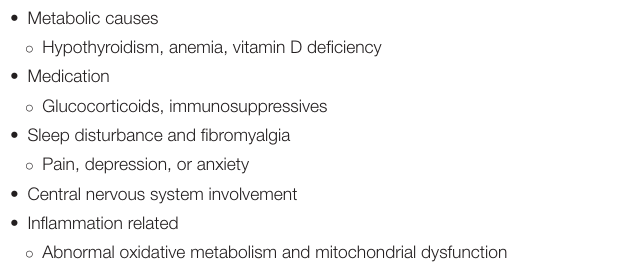
TABLE 3 | Possible contributors of